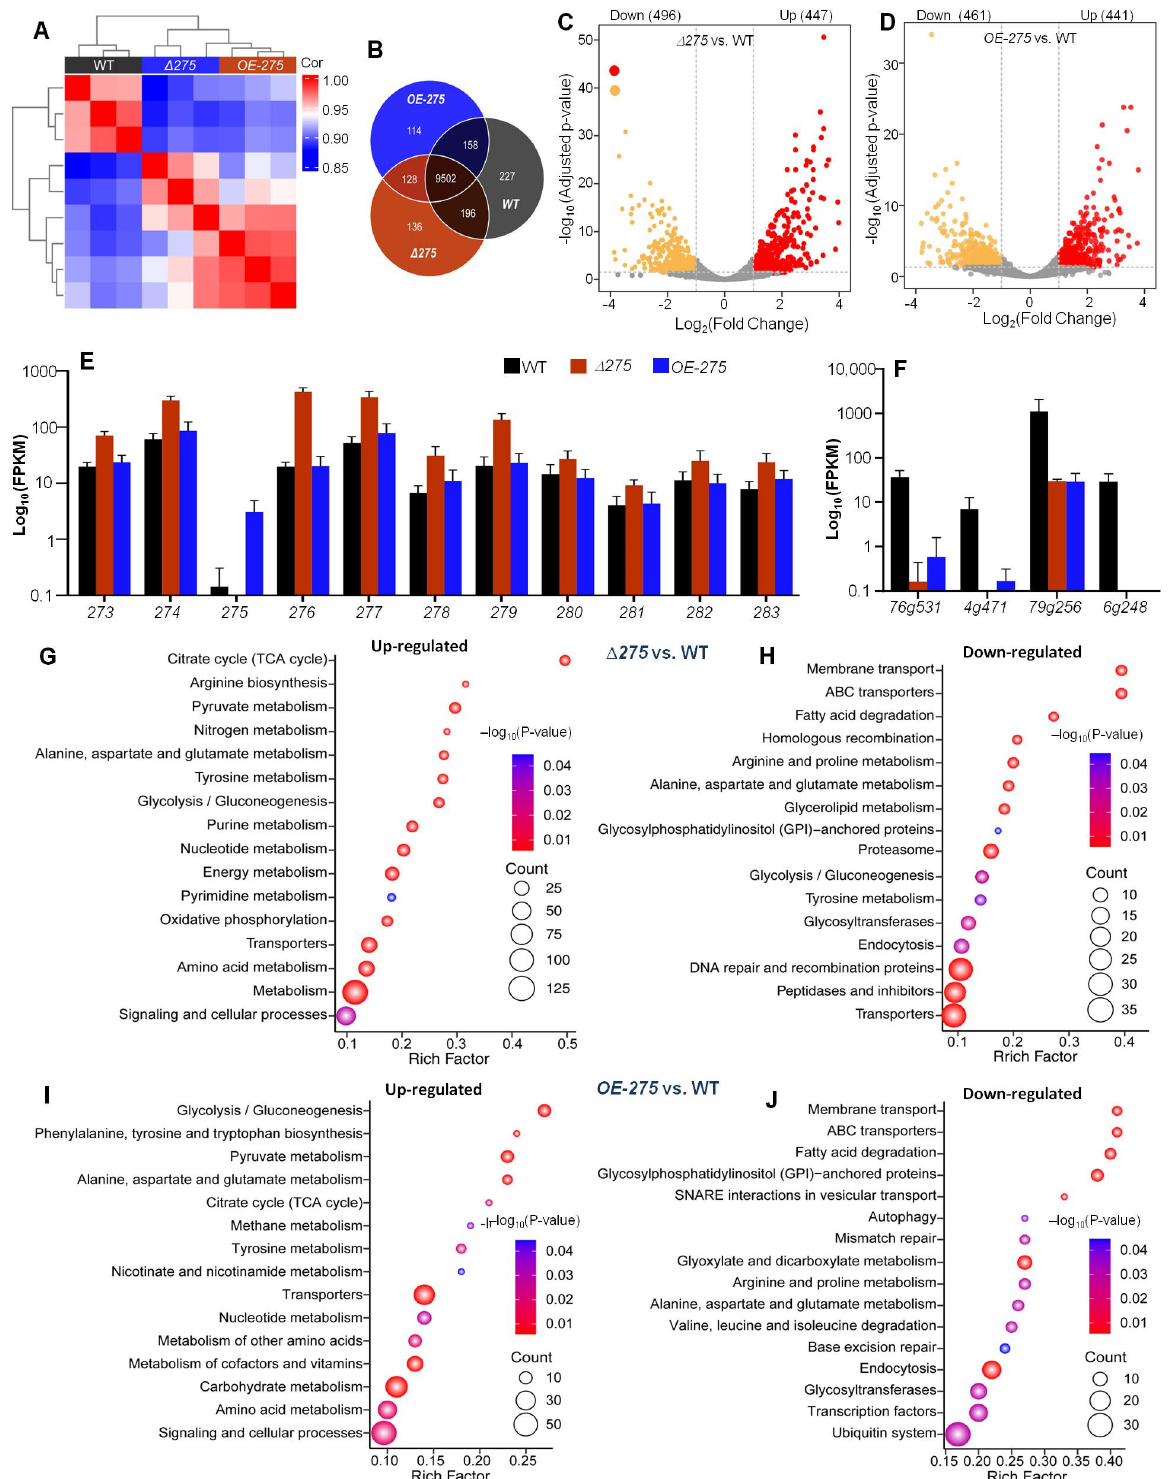
Figure 5. Transcriptomic analysis of Δ 275 , OE- 275 , and the WT: ( A ) Plot analysis of Pearson’s correlation ( r ) among the mutants ∆ 275 and OE- 275 and the WT. ( B ) Venn analysis for the numbers of significantly differentially regulated genes in ∆ 275 and OE- 275 , compared to the WT. ( C , D ) Volcano plot analysis of upregulated and downregulated genes in ∆ 275 and OE- 275 vs. the WT, respectively. ( E ) Comparison of the transcriptional levels of the genes in the PKS-PTS hybrid pathway in ∆ 275